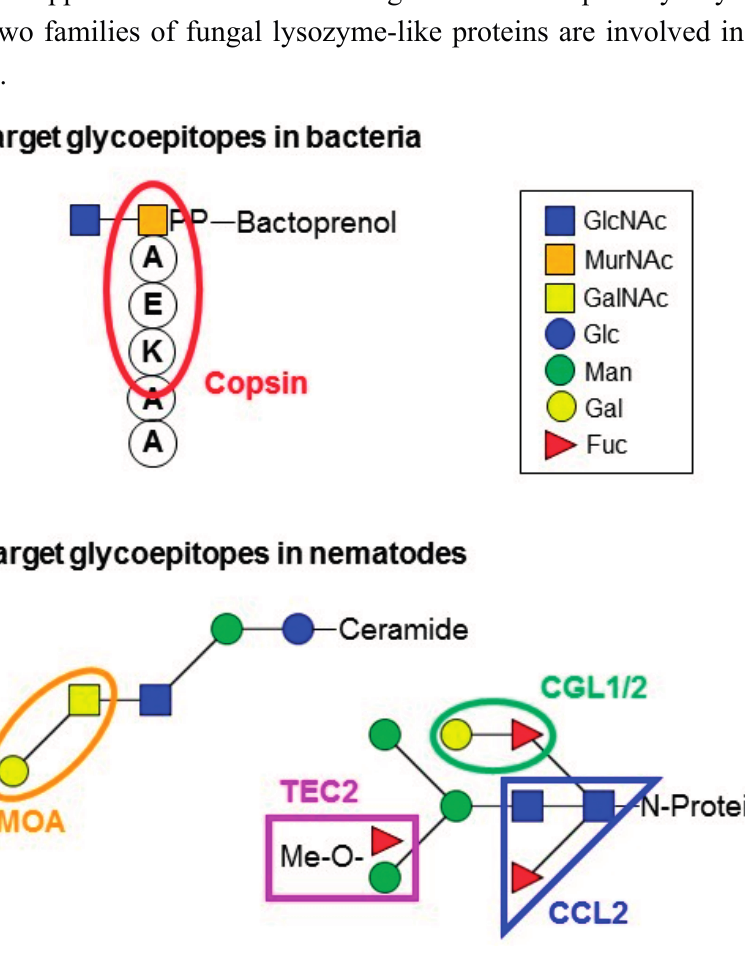
Figure 2. Examples of experimentally verified glycan targets of fungal defense proteins in bacteria and nematodes. The antibacterial Cs αβ defensin-like protein copsin from C. cinerea binds to the peptide (and eventually also the MurNAc) portion of lipid II [52]. The nematotoxic hololectins CGL1/2 and CCL2 from C. cinerea bind to specific